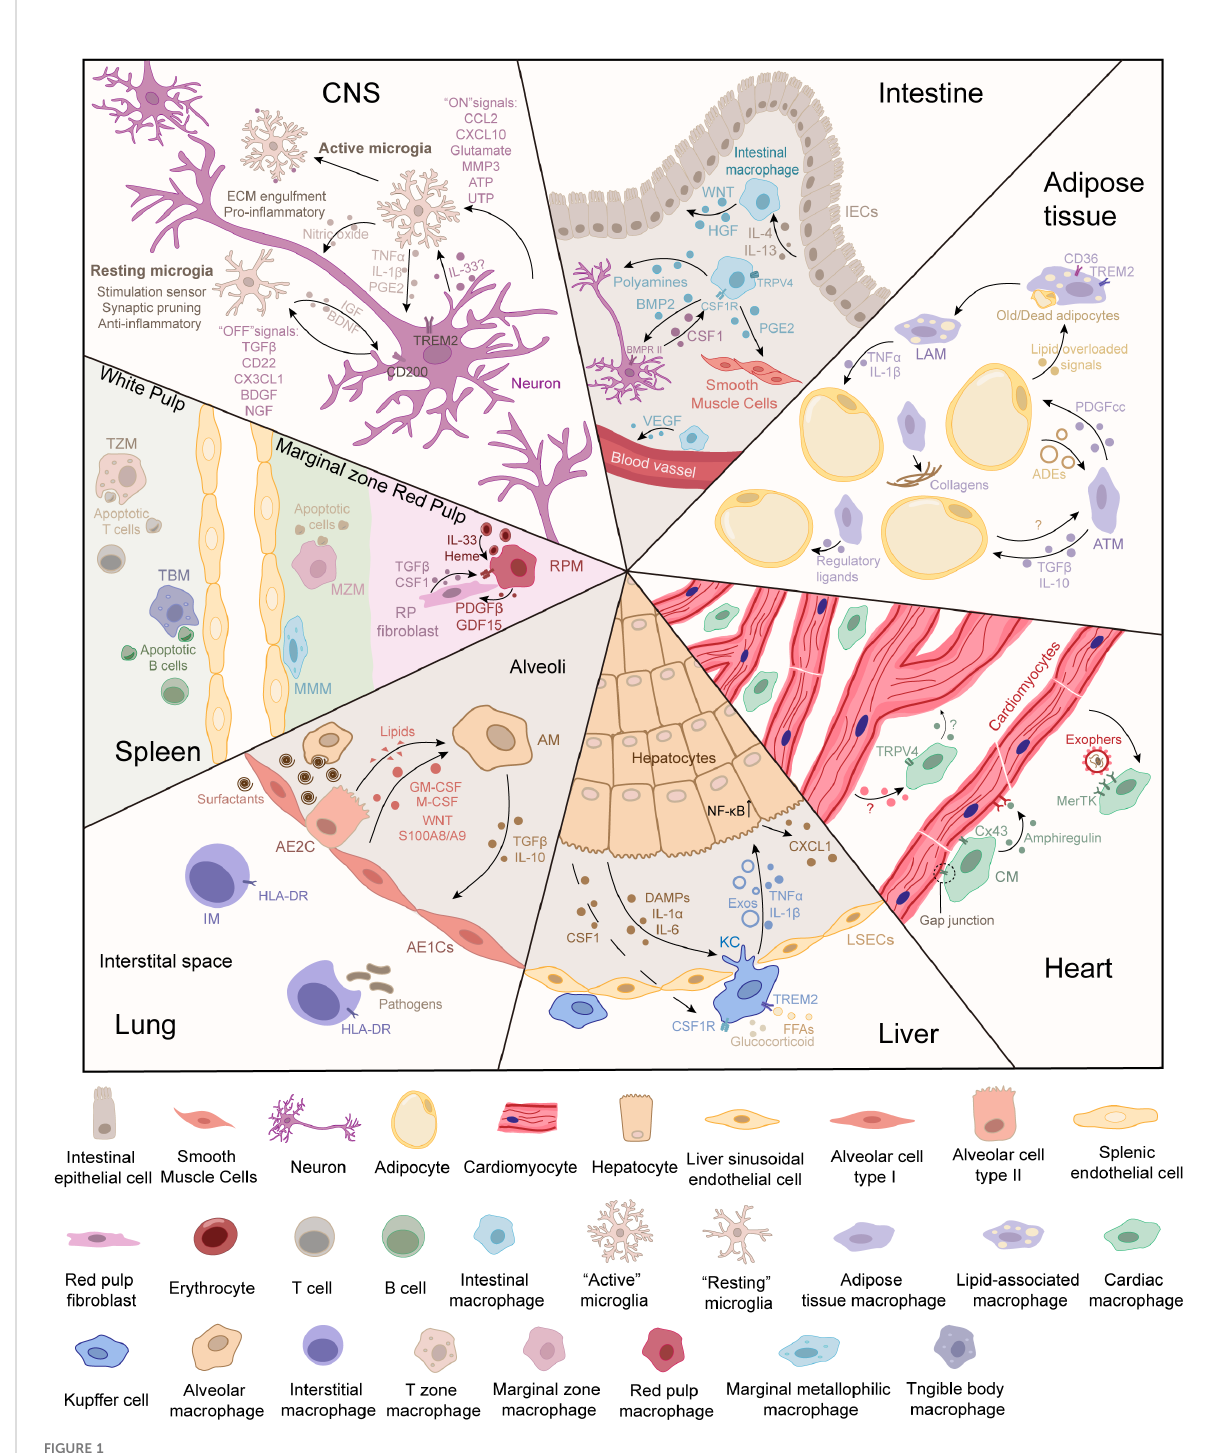
FIGURE 1 Cell communication between tissue-resident macrophages and parenchymal cells in different tissues. The parenchymal cells can be deemed the “ primary cells, ” which are responsible for performing the primary function of the tissue. During functions, parenchymal cells can release signals to inform the demand for or the accumulation of metabolites. Tissue-resident macrophages can be deemed “ supportive cells, ” which sense signals from the environment and parenchymal cells. In turn, tissue-resident macrophages respond to cell demand or modify the microenvironment to maintain the normal physiological functions of primary cells. The crosstalk between tissue-resident macrophages and parenchymal cells maintains tissue